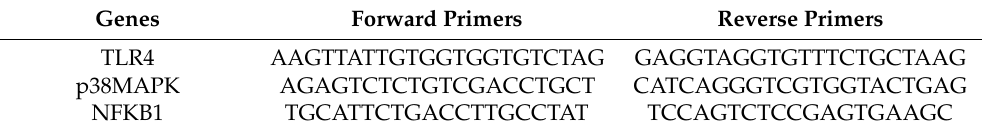
Table 1. Primers of